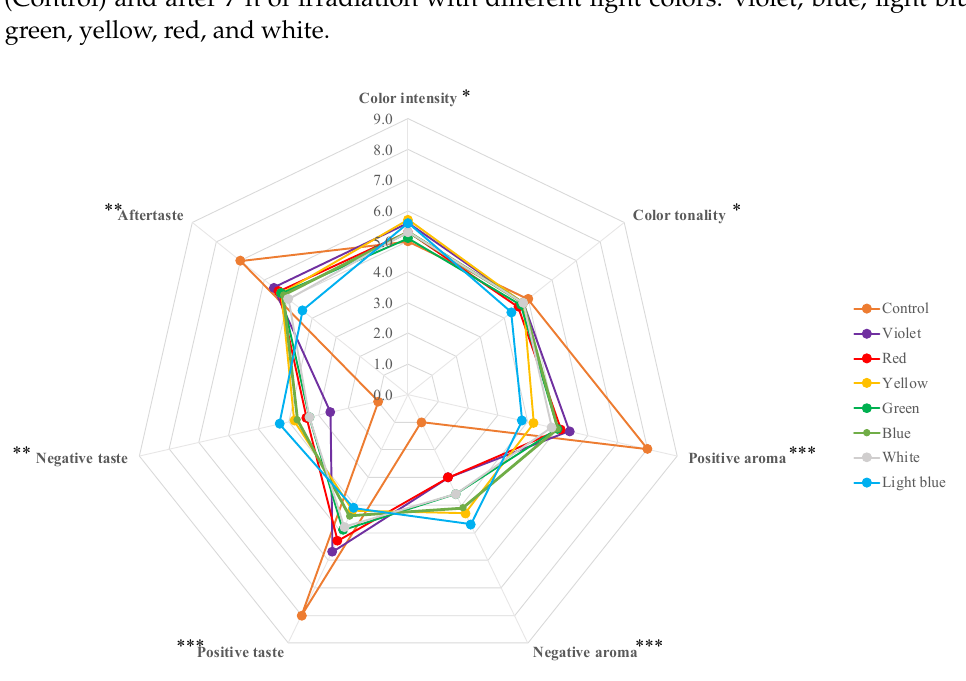
Figure 1. Sensorial analysis of Pinot Gris after 7 h and different light color exposures. * p < 0.05; ** p < 0.01; *** p <